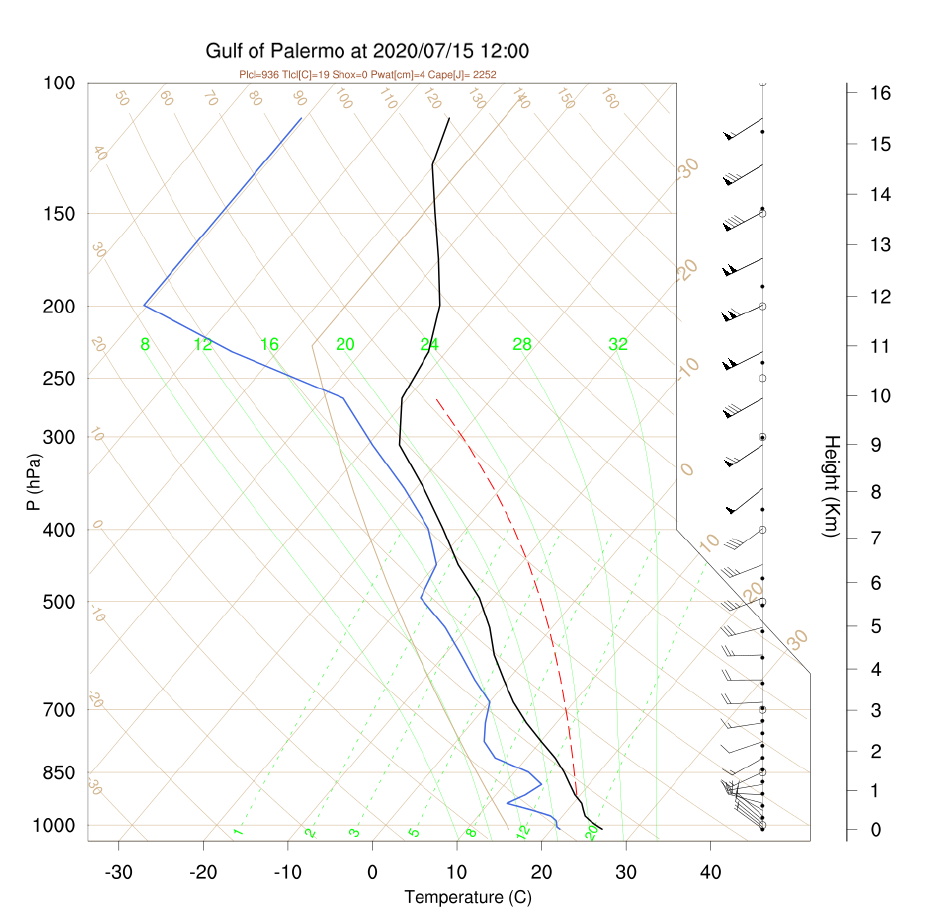
Figure 12. WRF Skew-T profile for a model grid point (Longitude 12.796 E Latitude 38.176 N) located in the Gulf of Palermo at 12:00 UTC of 15 July